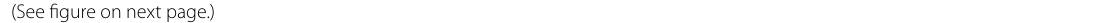
various left ventricle levels during end-systole (left) and end-diastole (right). b illustrates three-dimensional reconstruction of the left ventricle in the ROA view. Upper picture: in end-systole and lower picture in end-diastole. c Comparison of male and female mice cardiac PET parameters at different stages of follow up. Data of male mice are illustrated in blue, and female mice are in red. All groups n p < 0.05, ** p < 0.01, *** p <